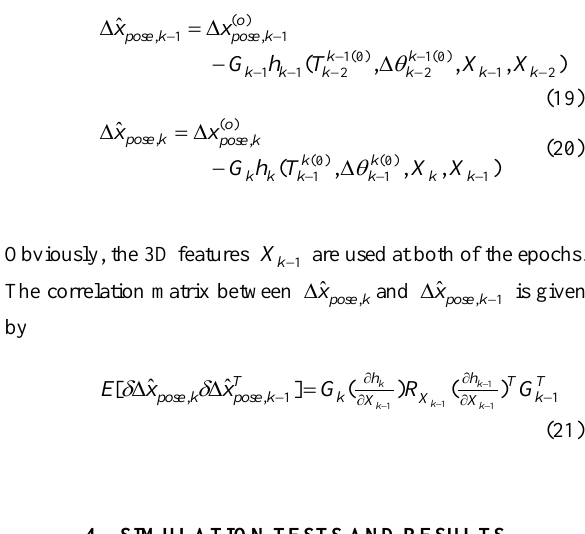
Figure 2. The velocity profile